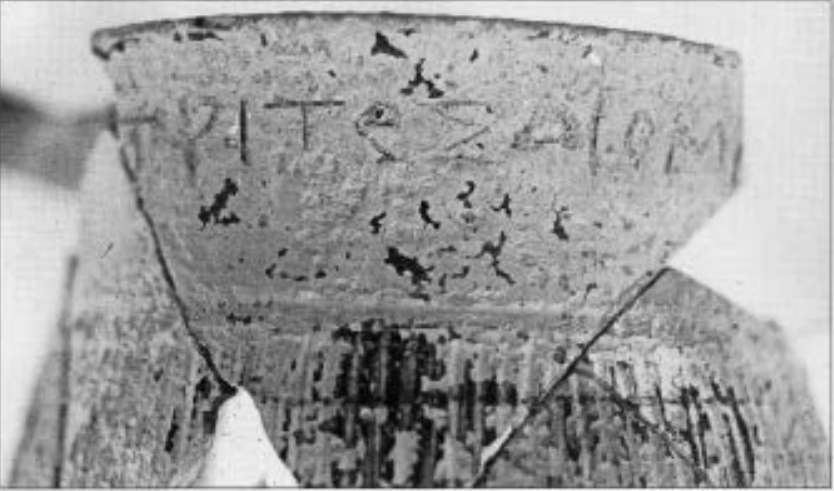
Fig ure 8 Dedication on rim of a cup from Punta Planka, width of upper rim c. 1 0 cm; one of the better preserved texts, with the name of the dedicator, Tritaios, and the recipi­ ent, Diomedes; probably second century